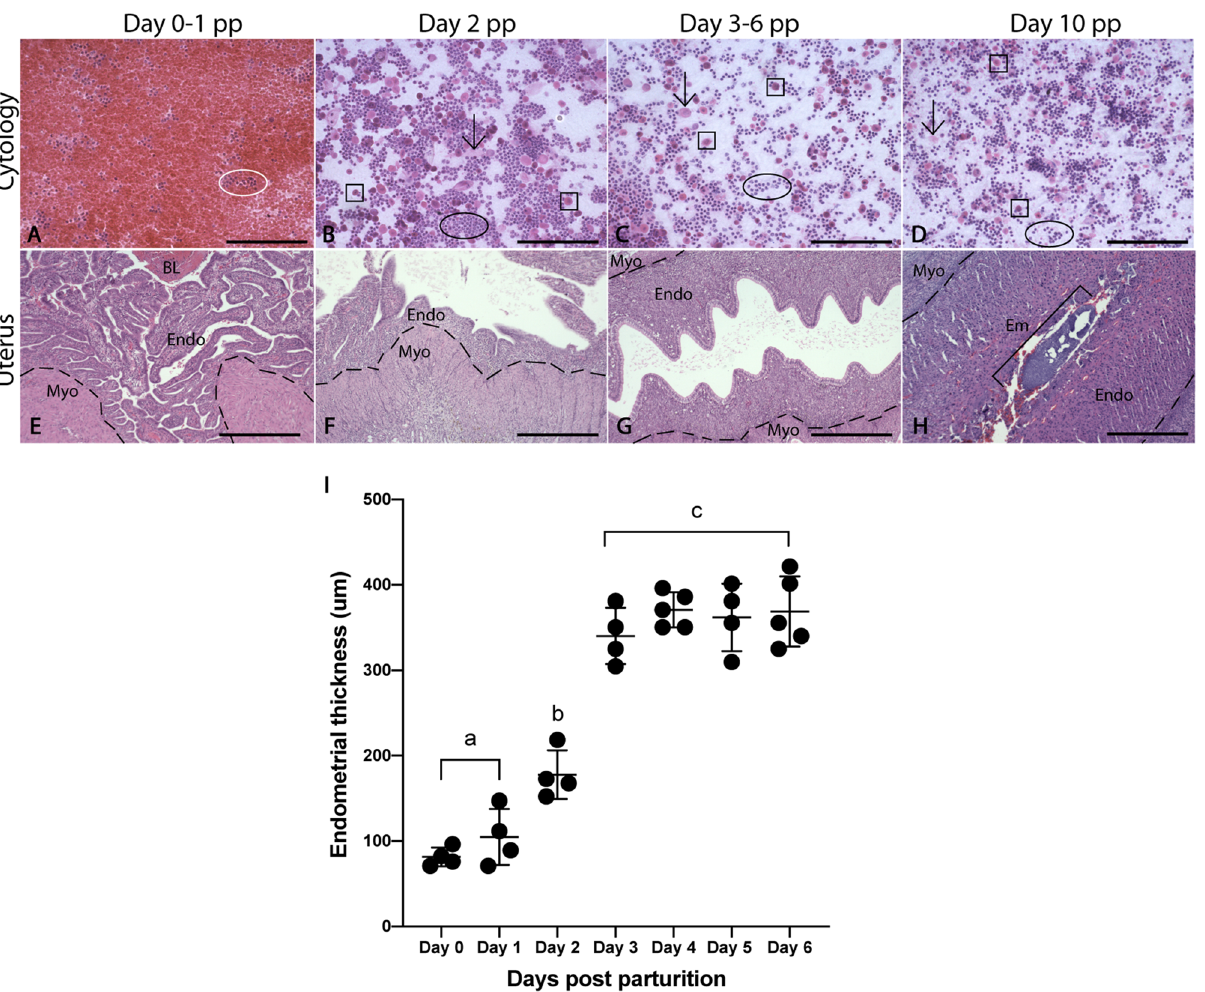
Figure 2. Comparative vaginal cytology and morphological changes to the postpartum uterus between time points. Vaginal cytology ( A – D ) across all remaining timepoints is dominated by leukocytes (circles) with a smaller number of CECs (arrows) and NECs (squares). Endometria on days 0–1 pp are thin (< 200 μm) and are not-significantly different but are significantly different to the remaining timepoints ( E , I ). On day 2 pp, the endometrium begins thickening rapidly and reaches maximum thickness by day 3 pp ( F – I ). Endometrial thickness on days 3–6 are similar ( I ). Day 10 data are excluded from analysis due to closure of the uterine lumen and regression of the luminal epithelium. Graphs depict mean ± SD and data with different letters differ significantly (p < 0.05; ANOVA). Myometrium (Myo), endometrium (Endo), embryo (Em). Scale bars are 100 μm for cytology ( A – D ) and 500 μm for uterine sections ( E – H